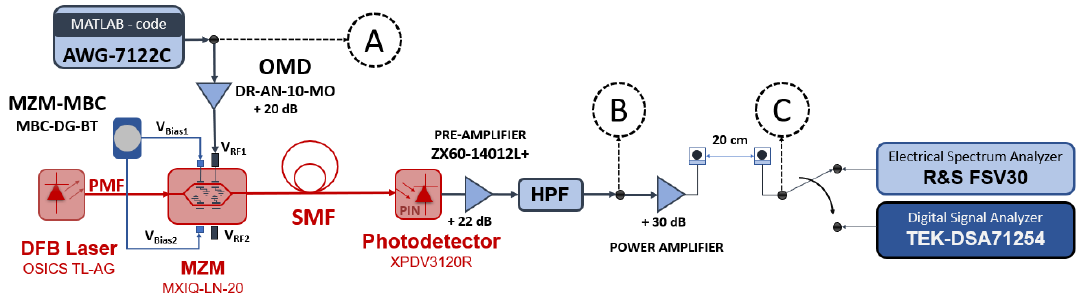
Figure 5. Setup diagram of the optical-wireless SLF IR-UWBoF IM/DD system. SLF: Spectral Line- Free; UWBoF: Ultra-Wideband over fiber; IM: Intensity Modulation; DD: Direct Detection; SMF: Single Mode Fiber; PMF: Polarization-maintaining optical fiber; DFB: Distributed-Feedback Laser; MZM: Mach Zehnder Modulator; MBC: Modulator Bias Controller; OMD: Optical Modulator Driver; HPF: High Pass Filter.